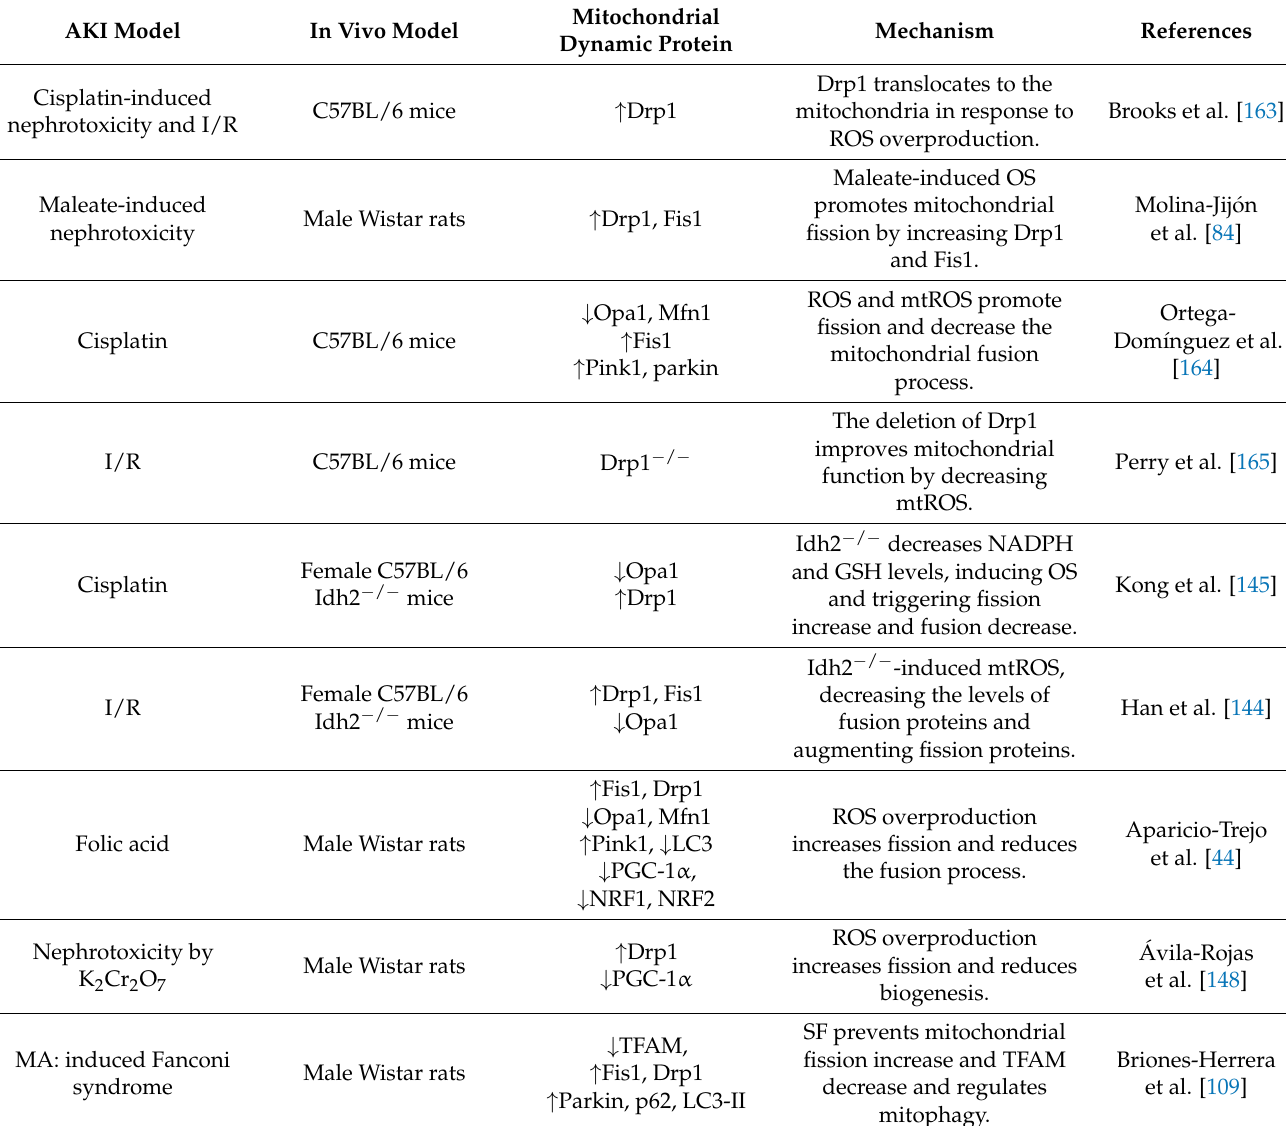
Table 1. ROS regulate mitochondrial dynamics, biogenesis, and mitophagy in acute kidney injury (AKI)